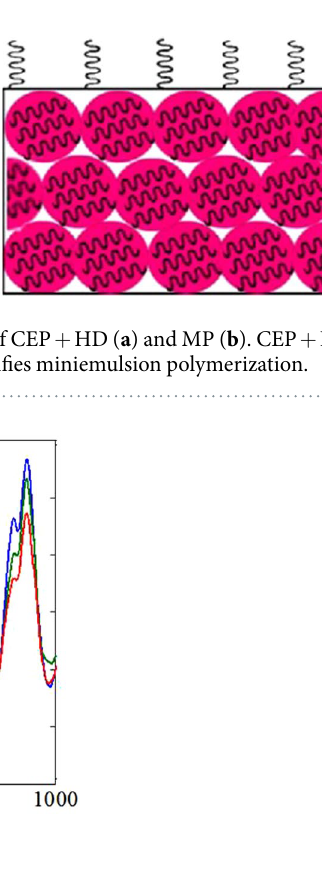
Figure 7. FTIR-PAS of CRU prepared with via CEP, CEP + HD and MP(900,3). CEP denotes conventional emulsion polymerization, CEP + HD represents the emulsion containing HD synthesized by CEP, MP (900,3) signifies miniemulsion polymerization through homogenizer pressures of 900 bar, and pass number of